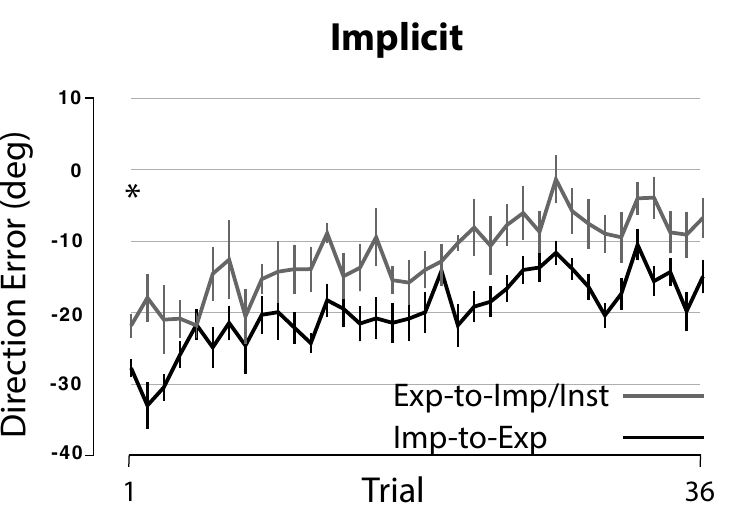
Fig 5. Changes in performance across trials in Imp-to-Exp and Exp-to-Imp/Inst groups. Each data point represents mean DE for a given trial. Performance changes across trials for Imp-to-Exp and Exp-to-Imp/Inst groups are shown separately. � indicates significant difference, p <